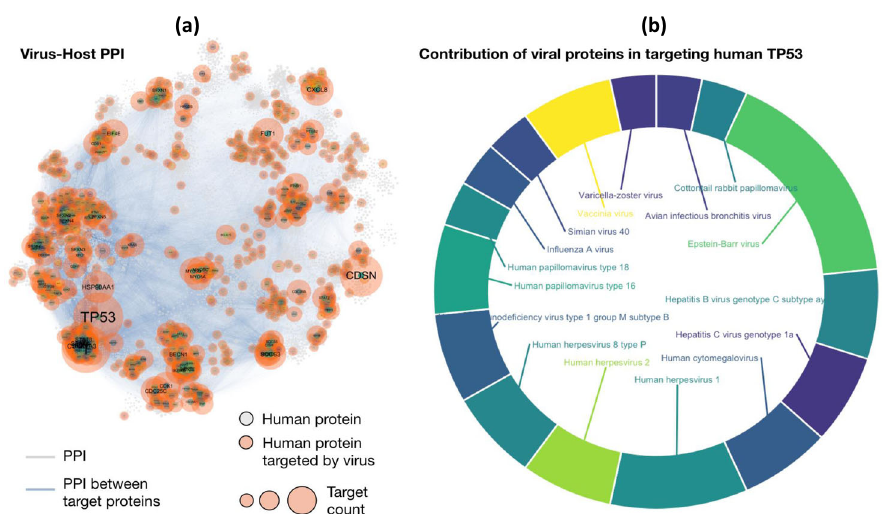
Fig. 2 Virus – host interactome as an interdependent network. BIOSTR human PPI (protein – protein interactions) used in this study, is obtained from data fusion of two comprehensive public repositories, namely STRING and BIOGRID (see the text for details). The network consists of N = 19,945 proteins linked by ∣ E ∣ = 737,668 edges, and the largest connected component (99.8% nodes, 99.6% edges) is shown ( a ). Proteins targeted by viruses are highlighted in two ways. On the one hand, markers of distinct size identify targeted proteins: bigger the marker larger the number of times a protein is targeted by viruses in our dataset. On the other hand, distinct colored markers of constant size encode distinct viruses (93 in total, including SARS-CoV-2) and the same color scheme is used to show the contribution of each virus to one of the most frequently targeted proteins ( b ), TP53, as an example. See Supplementary Figs. 1 – 3 for more information on the contribution of viruses in targeting a number of other human